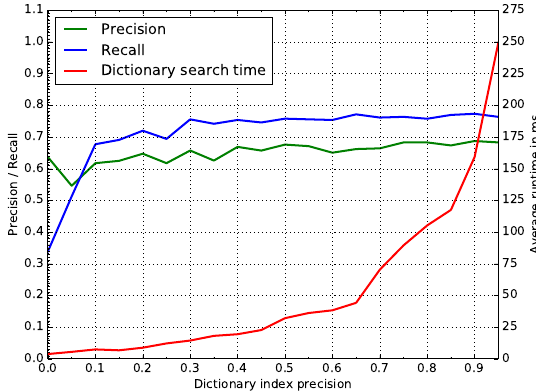
Figure 10. Different desired precisions for the search index